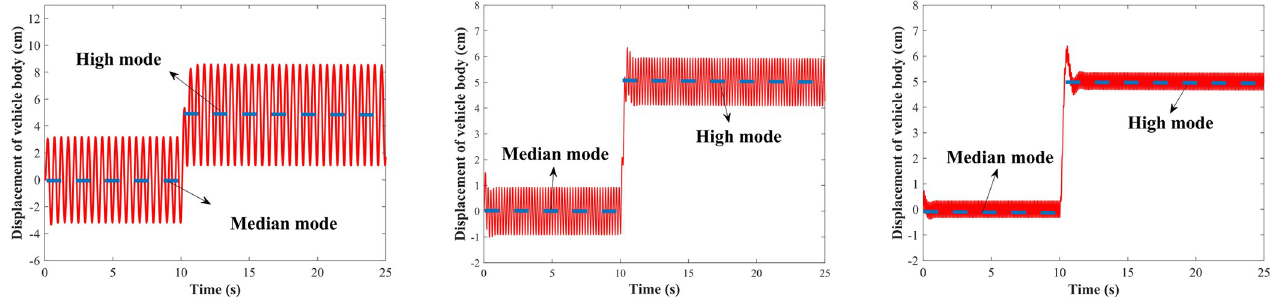
Fig 14. Median mode to high mode under the sinusoidal road. (A) f = 2 Hz; (B) f = 5 Hz; (C) f = 10 Hz.